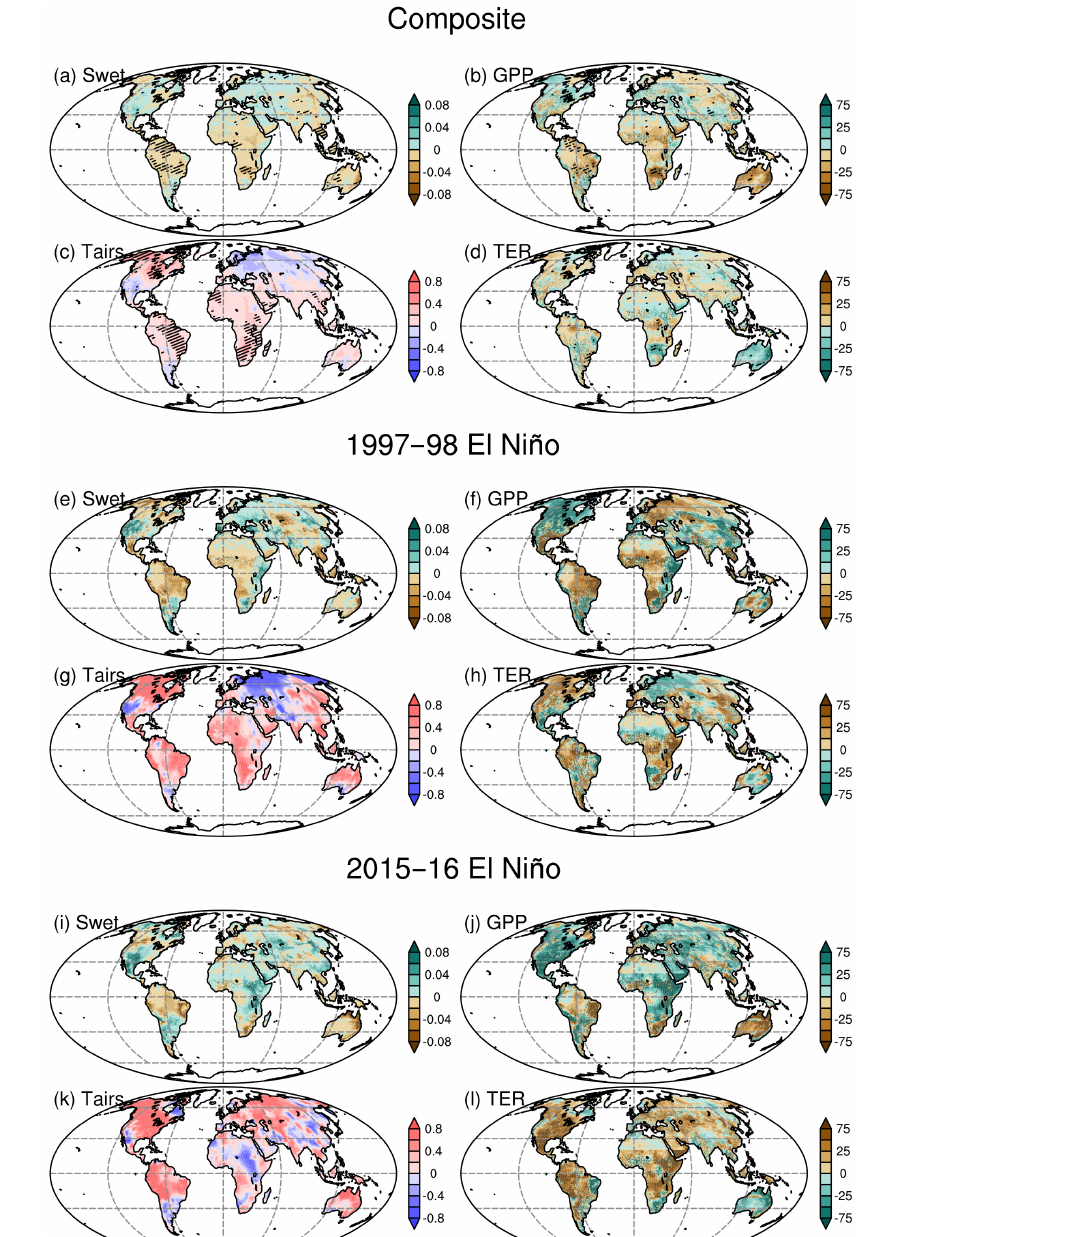
Figure 6. Anomalies of soil wetness, air temperature (units: K), GPP (gCm − 2 yr − 1 ), and TER (gCm − 2 yr − 1 ) from July in the El Niño developing year to October in the El Niño decaying year in the composite, 1997/98, and 2015/16 El Niño episodes, respectively. (a–d) Results of the composite analyses. The stippled areas are significant above the 90% levels estimated by Student’s t test. (e–h) Anomalies during the 1997/98 El Niño. (i–l) Anomalies during the 2015/16 El